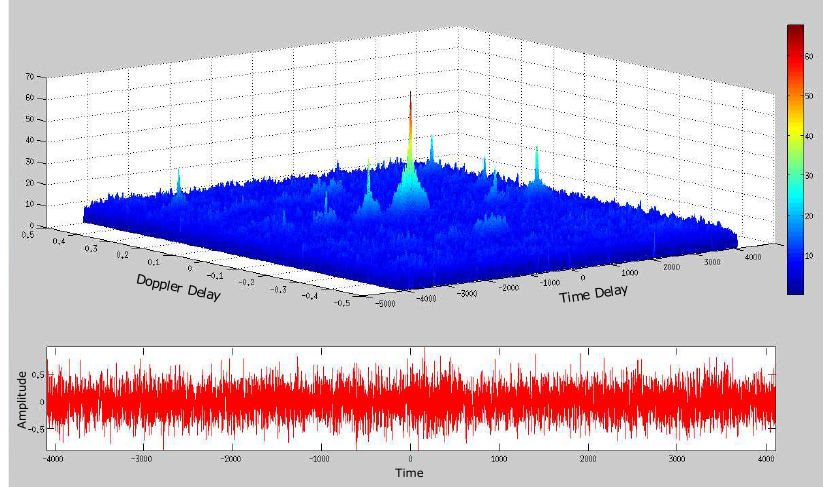
Figure 26. Multiple object tracking using MMPP “chirp pulses”, at Tracking Time 1, with − 5 dB SNR.